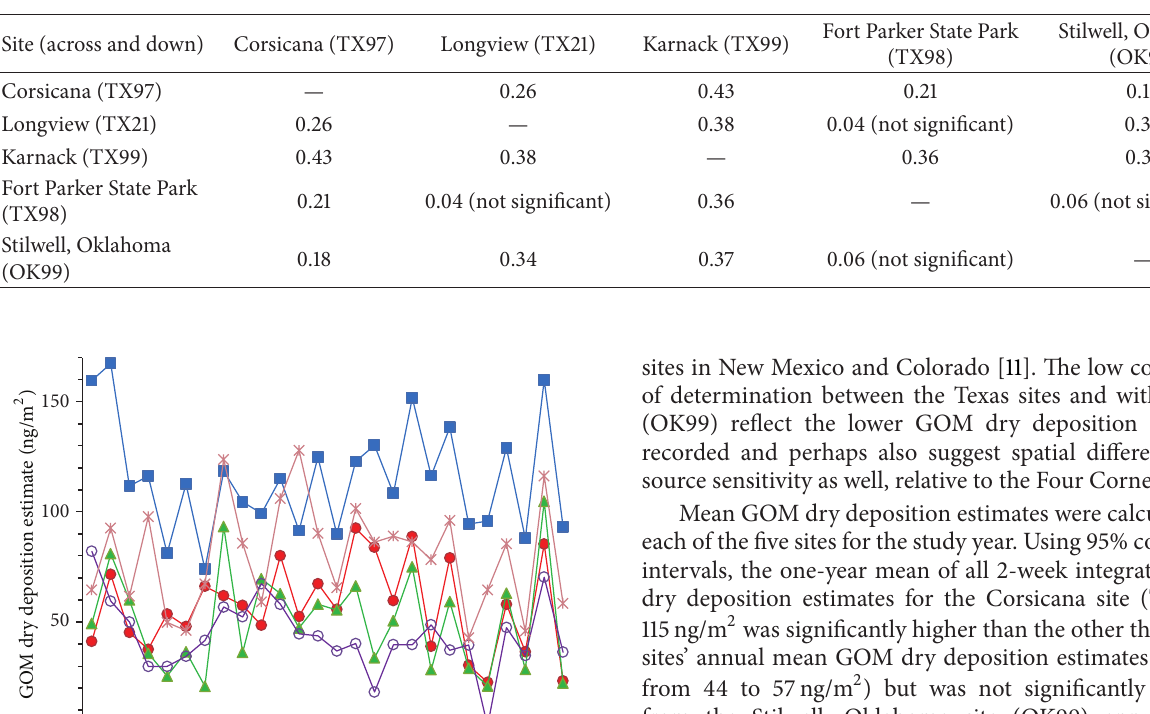
Table 1: Coefficients of determination (𝑟 2 ) for Texas and Stilwell, Oklahoma GOM smooth-edge surrogate surface passive sampling sites. All values significant at 𝑃 < 0.05 except as noted.